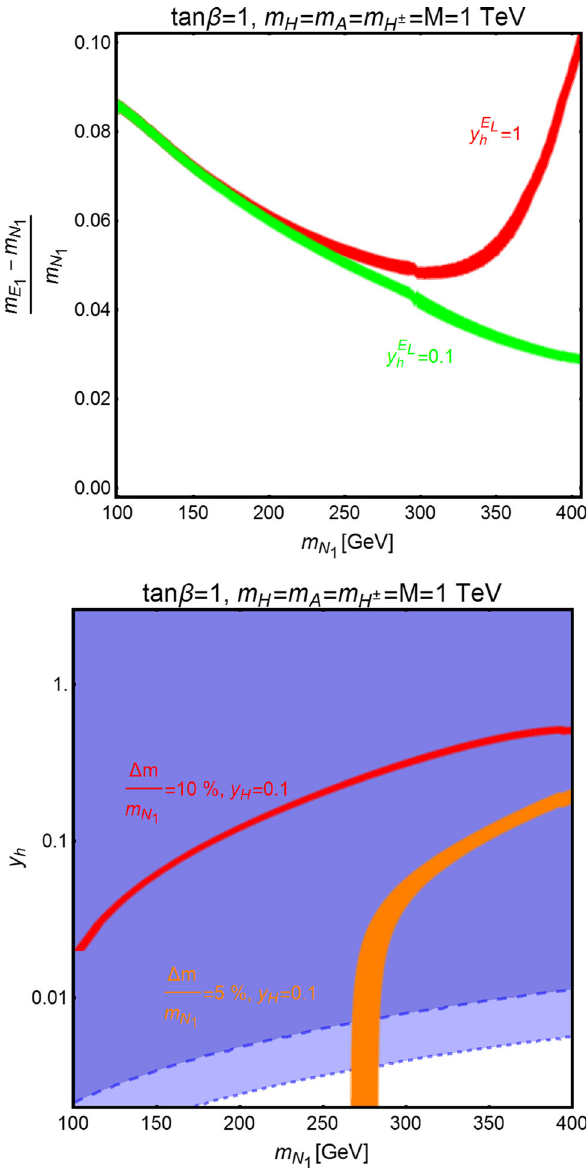
Fig. 10 Top panel isocontours of the correct DM relic density in the , m E 1 − m N 1 ) for tan β = 1, y N R = y E R = 0, bidimensional plane ( m N h h m N 1 1 = 5 × 10 − 3 , and two assignations of y E L = y N L = − y N R = y N L h h H H = y E R − y E L , i.e. 0.1 and 1. Notice that we have set M = m H = m A = H H m H ± = 1TeV. Bottom panel isocontours of the correct relic density, − m N = y E L 1 , for two values of m E 1 , namely 5 and 10%, assuming y N L h h m N 1 and the corresponding excluded region by LUX, in, respectively, blue and dark blue vided that the relative mass splitting between the DM and the lightest charged state is between approximately 2 and